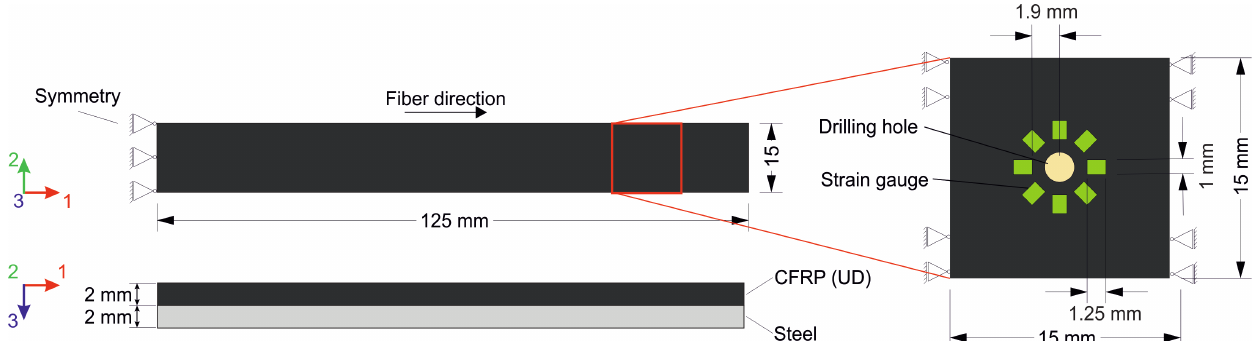
Figure 2. On the left side, the geometry and boundary conditions of the considered metal/CFRP hybrid are shown. Due to the symmetry within the 2–3 plane, the displacement is freezed. The derived submodel, as well as the arrangement of the drilled hole and the strain gauges, are shown on the right side.